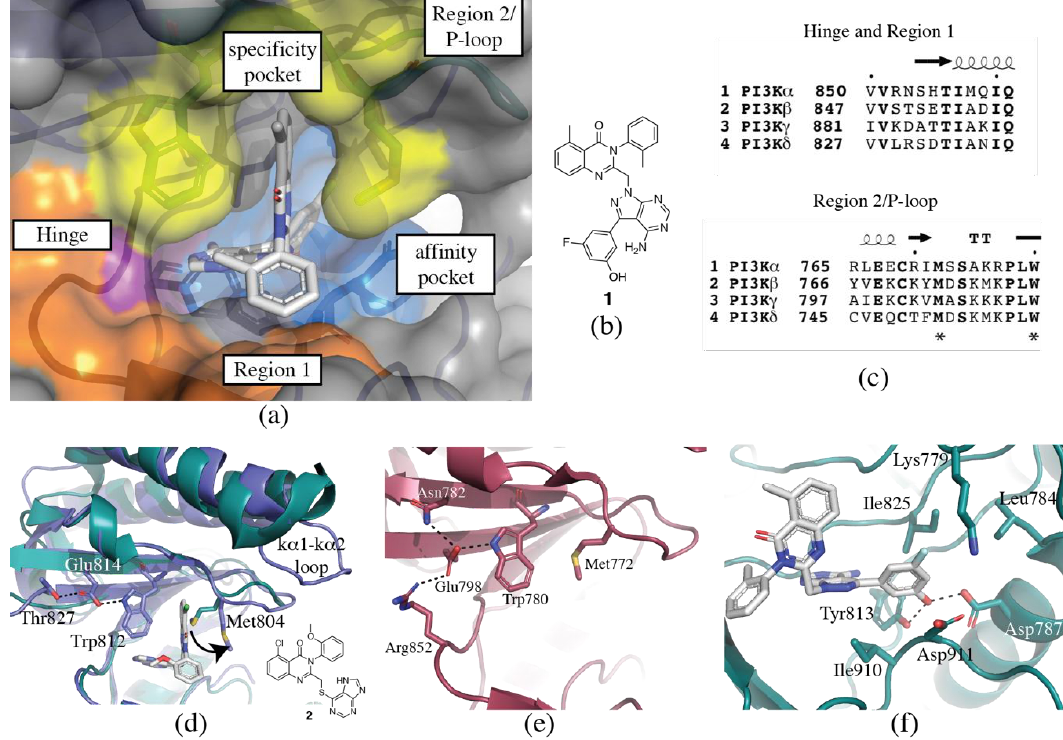
Figure 2. Regions of the binding site. ( a ) Overall picture of the inhibitor binding site with 1 bound (p110 δ , PDB ID 2WXG). The hinge region is shown in purple, the affinity pocket in blue and the open specificity pocket in yellow. Region 1 is shown in orange. The P-loop is shown in teal. ( b ) Structure of 1 . ( c ) Sequence alignment of hinge and Regions 1 and 2. ( d ) The specificity pocket in p110 δ and p110 γ . p110 δ is shown in teal (PDB ID 2WXG) and p110 γ is shown in slate (PDB ID 2CHW). The movement of γ Met804 required for opening of the specificity pocket is marked by an arrow. PIK39 2 is shown in the binding site. The extended loop between the k α 1 and k α 2 helices in p110 γ is indicated, along with the stabilizing hydrogen bond interactions with γ Trp812. ( e ) Stabilizing interactions of α Trp780 in p110 α (PDB ID 4JPS). ( f ) The affinity pocket. The structure of 1 bound to p110 δ (PDB ID 2WXG), with key residues in the affinity pocket marked.